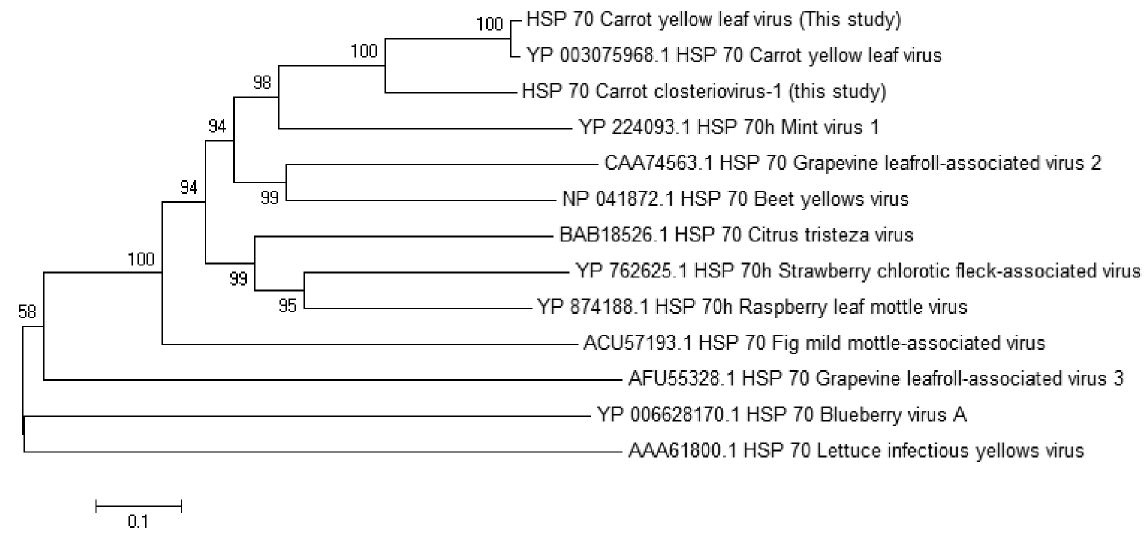
Figure 4. Bootstrapped neighbour joining tree of HSP70 proteins from viruses within the family Closteroviridae constructed with MEGA5 using 500 replicates.